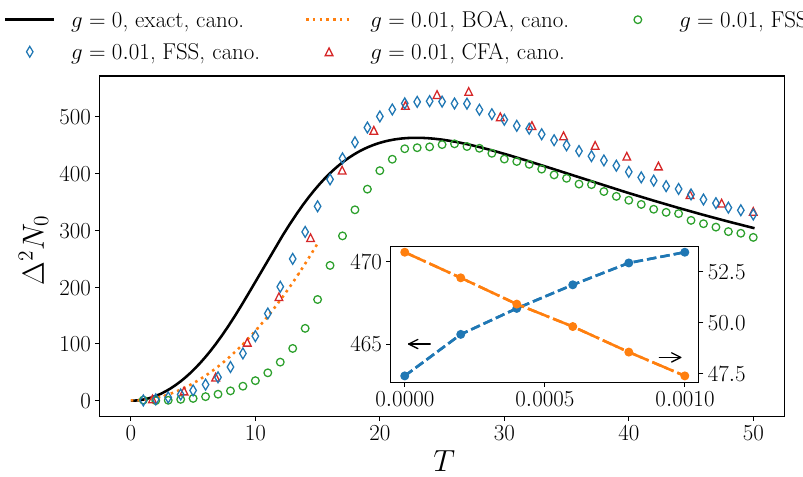
Figure 3: Fluctuations of a weakly-interacting Bose gas containing N = 100 atoms in a 1D ring trap. The variance of N as a function of temperature is obtained from 0 several different approaches: FSS method, classical field approximation, and Bogoli- ubov approach. A microcanonical calculation shows a significant suppression of the fluctuations. The exact canonical result from Fig. 2 is shown for comparison. (inset) Variance at a low temperature T = 5 (orange, axis on the right) and at the temper- ature of maximal fluctuations (blue, axis on the left) as a function of the interaction strength g , obtained with the FSS method in the canonical ensemble. The arrows in- dicate the appropriate axis. The interaction strength g and temperature T are given L 2 ) in units 2 ħ h 2 π 2 / ( mL ) and 2 π 2 ħ h 2 / ( mk B